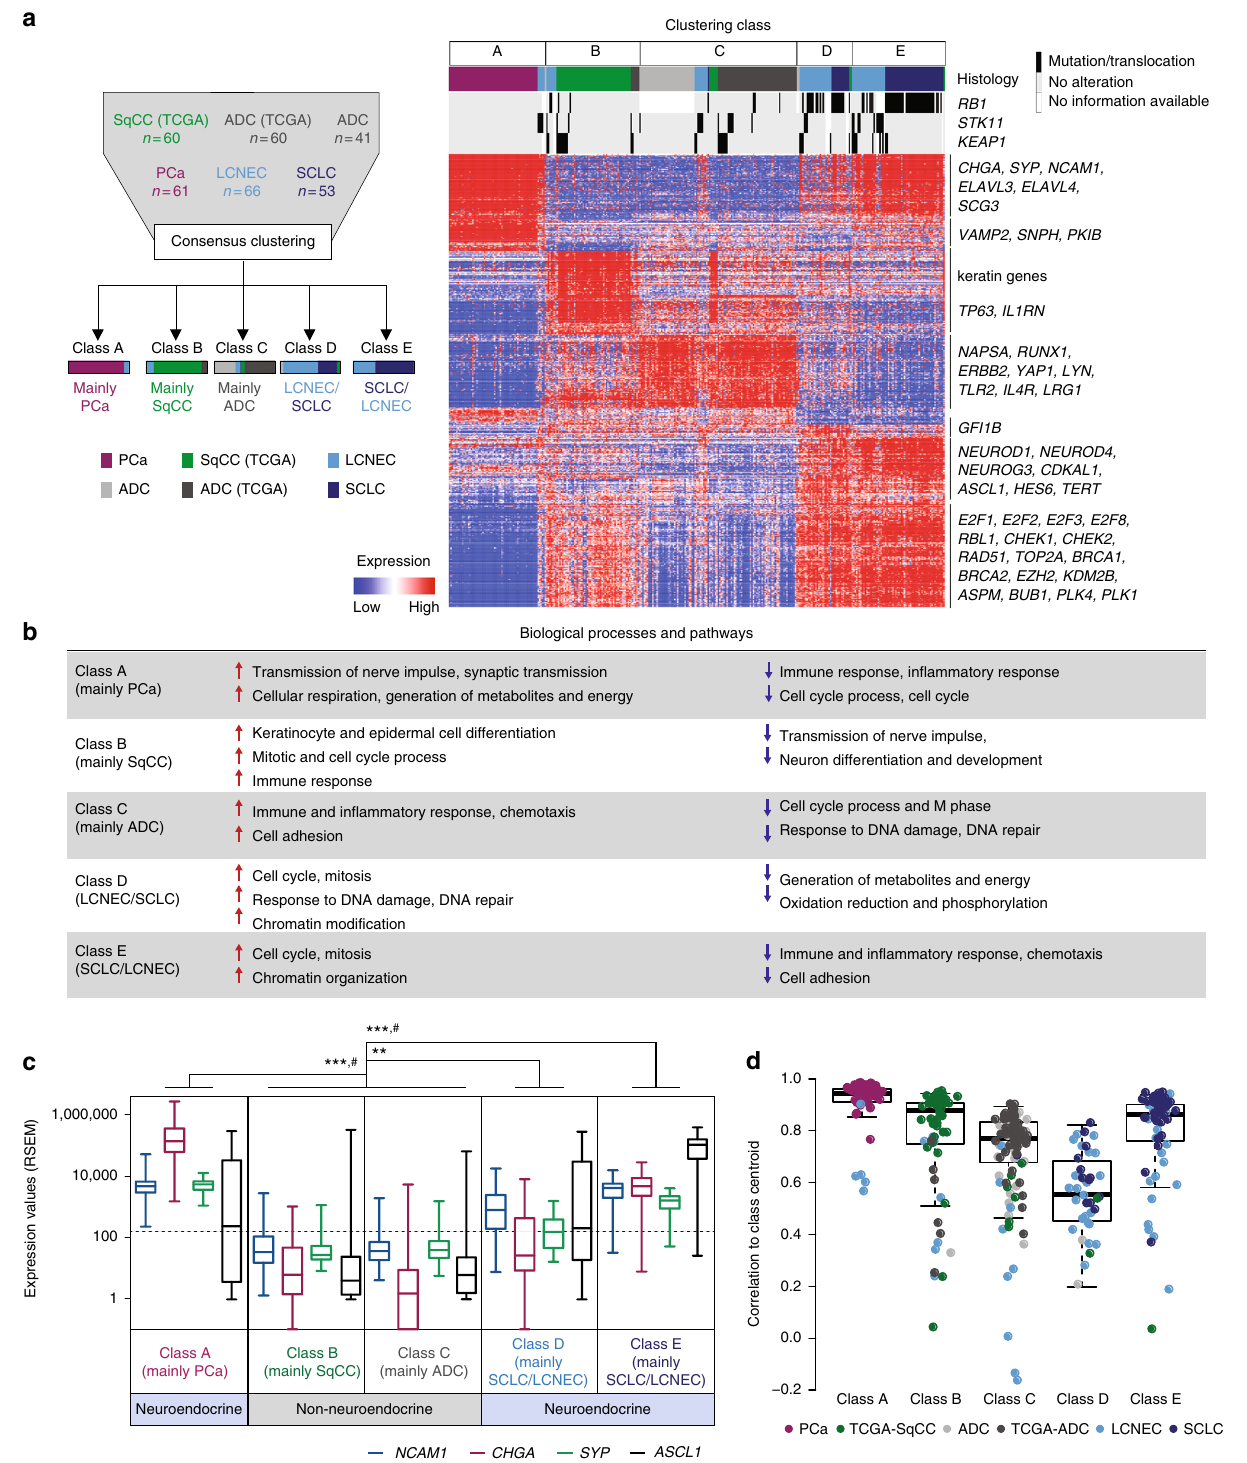
Fig. 2 Gene expression studies on lung cancer subtypes. a A schematic description of the unsupervised consensus clustering approach is provided on the left panel. The clustering results are displayed on the right panel as a heatmap, in which tumor samples are arranged in columns, grouped according to their expression clustering class, annotated for the histological subtype and for the somatic alteration status. Expression values of genes identi fi ed by ClaNC (Methods section) are represented as a heatmap; red and blue indicate high and low expression, respectively. Selected candidate genes are shown on the right. b Signi fi cant enrichment of differentially expressed genes in signaling pathways is displayed for all clustering classes ( P < 0.0001, Methods section). c Expression values for key neuroendocrine differentiation markers are plotted for each clustering class as box-plots (median and interquartile range, whiskers: min – max values). Dashed black lines indicate the threshold for low expression (Methods section). Q < 0.05 (#), signi fi cance determined by SAM (Supplementary Dataset 12); P < 0.001 (***) Mann – Whitney U -test. d The correlation of each sample to the centroid of its clustering class was calculated and displayed as box-plot (median and interquartile range, whiskers 5 – 95